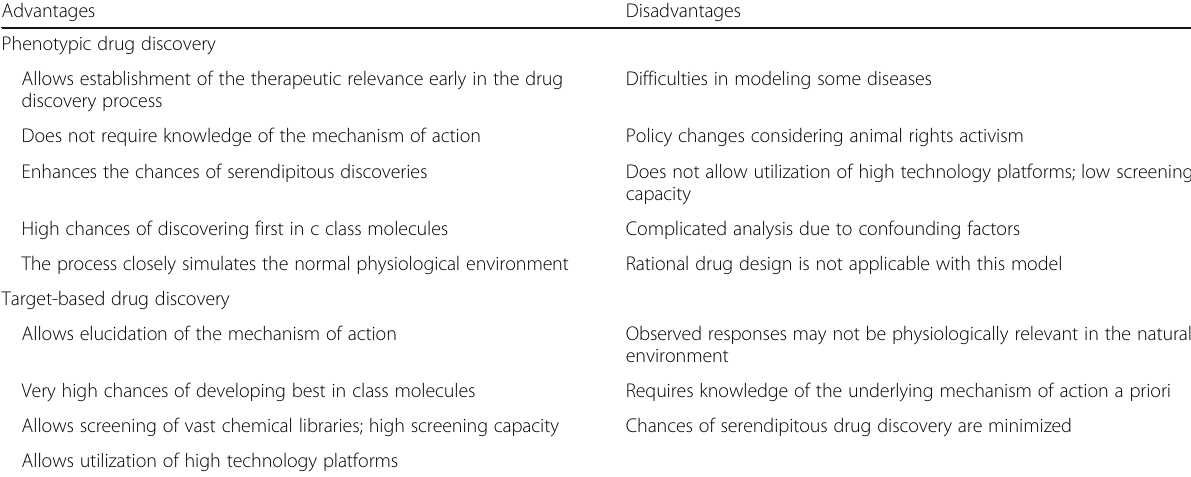
Table 1 Advantages and disadvantages of phenotypic and target-based drug discovery approaches Advantages Disadvantages Phenotypic drug discovery